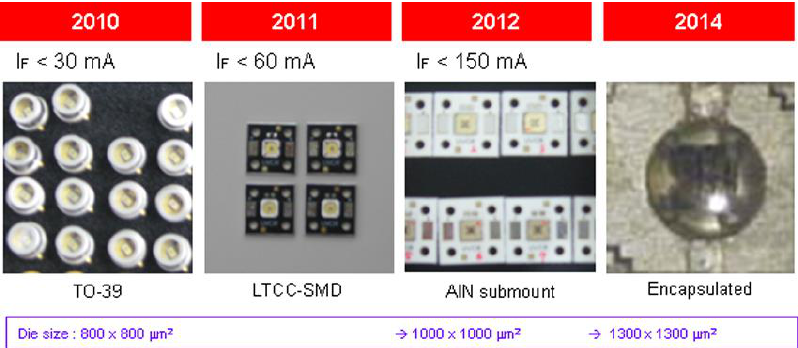
Figure 2. Demonstration samples of DUV-LEDs fabricated by UV Craftory Co., Ltd. Until 2014, the effect of the miscut angle of sapphire [13] was studied to increase EQE. In parallel, the heat dissipation was improved and the chip size was increased to obtain higher output power. A thick p-GaN layer is considered to be necessary to obtain a longer lifetime and to reduce device faults. Since 2012, resin encapsulation using fluorine polymers has been intensively investigated [14] to increase the extracted electroluminescence (EL). (Photographs are permitted to be reused from Oyobutsuri [22] (in Japanese). © Japan Society Applied Physics.).